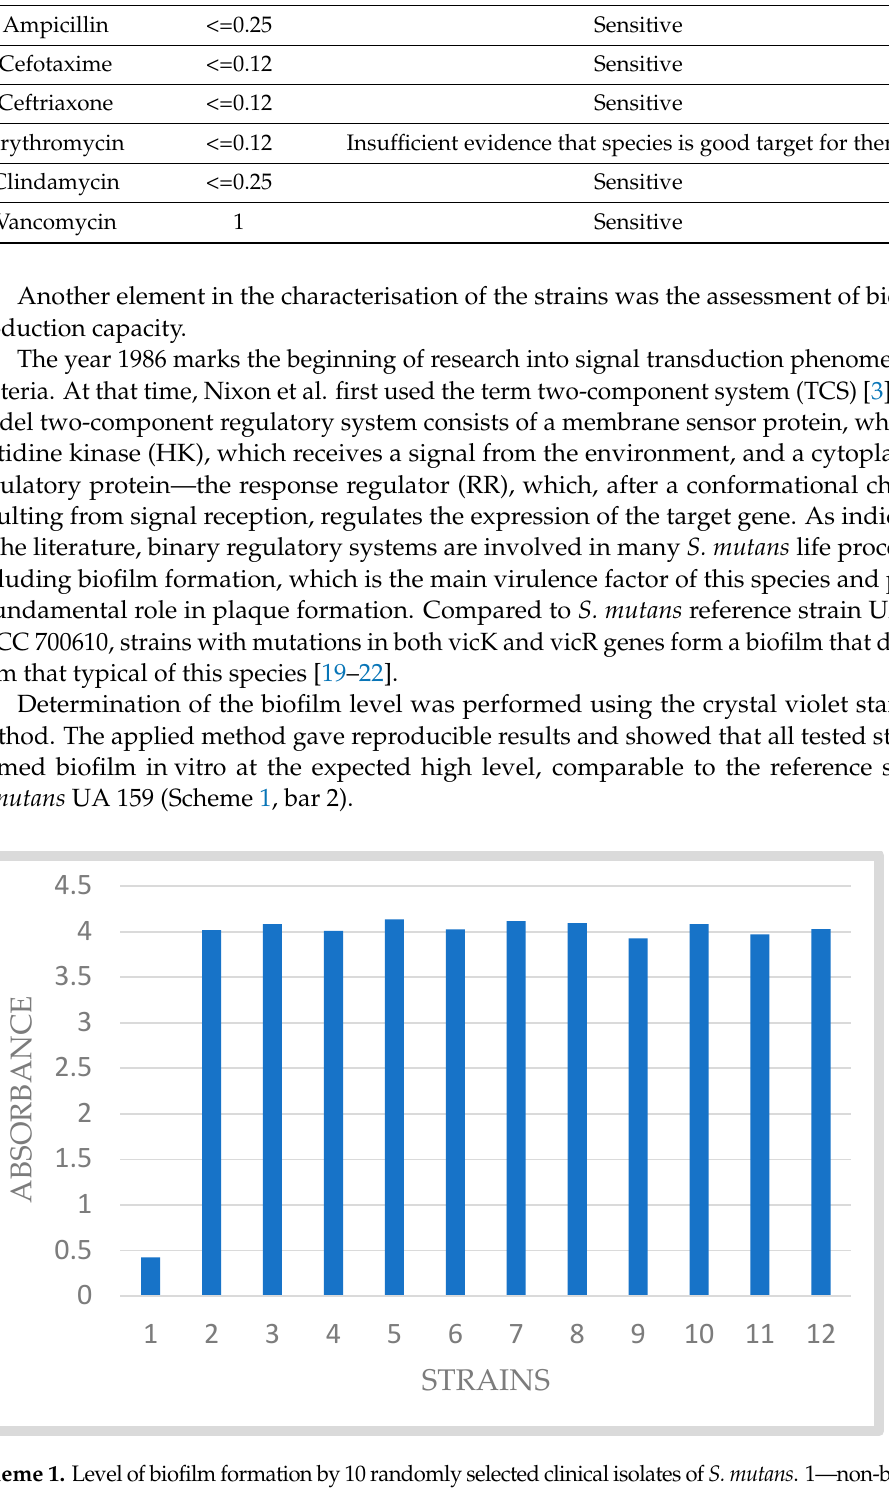
Table 4. Drug susceptibility panel—AST-ST01 Card (bioMerieux). Antimicrobial MIC Interpretation Benzylpenicillin <=0.06 Sensitive Ampicillin <=0.25 Sensitive Cefotaxime <=0.12 Sensitive Ceftriaxone <=0.12 Sensitive Erythromycin <=0.12 Insufficient evidence that species is good target for therapy Clindamycin <=0.25 Sensitive Vancomycin 1 Sensitive